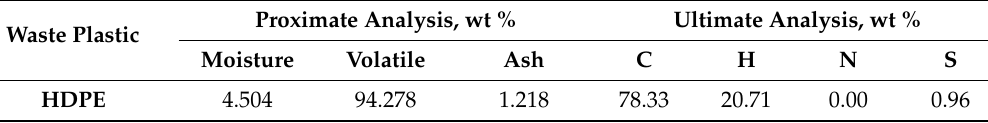
Table 1. Ultimate and proximate analysis of high-density polyethylene (HDPE). Waste